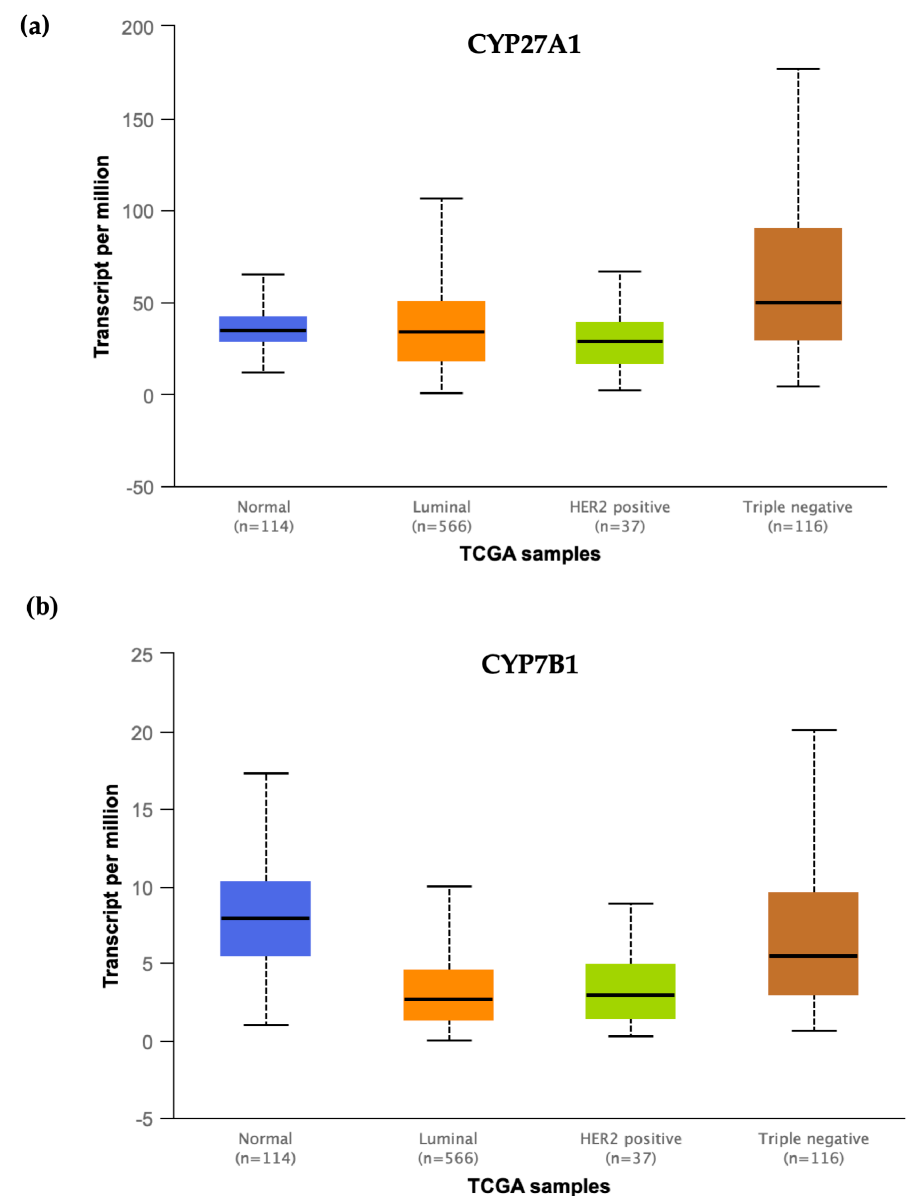
Figure 2. mRNA expression of CYP27A1 and CYP7B1 in different subtypes of breast cancer. ( a ) The expression level of CYP27A1 is significantly upregulated in TNBC compared to normal tissues ( p -value < 10 − 6 ), while it is not different in ER-positive or HER2-positive group compared to the normal group ( p -value > 0.5). ( b ) CYP7B1 mRNA expression is significantly lower in both luminal ( p -value < 10 − 11 ) and HER2-positive ( p -value < 10 − 5 ) tumor groups compared to normal breast tissues, while it is not different in TNBC compared to normal tissues ( p -value > 0.5). The expression data are based on the TCGA data and visualized by the UALCAN portal [69].